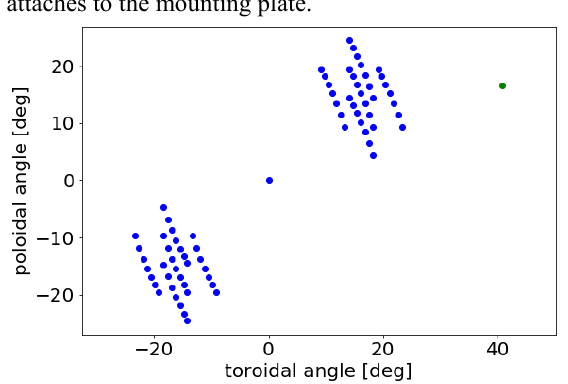
Fig. 6. Anticipated steering range for mid-plane launcher. Two groups of points represent co- and counter- directions; points cover range of plasma parameters.